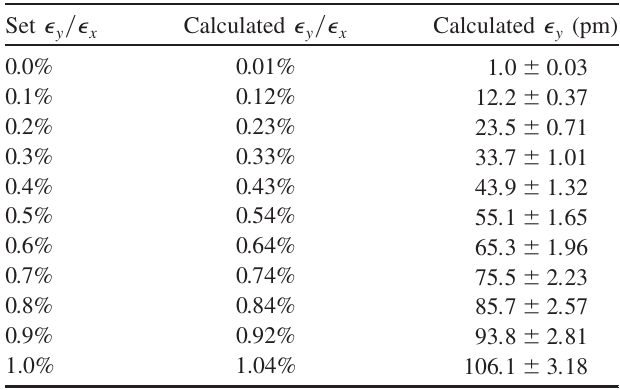
TABLE II. Results from the analysis of the LOCO calibrated models for each emittance ratio